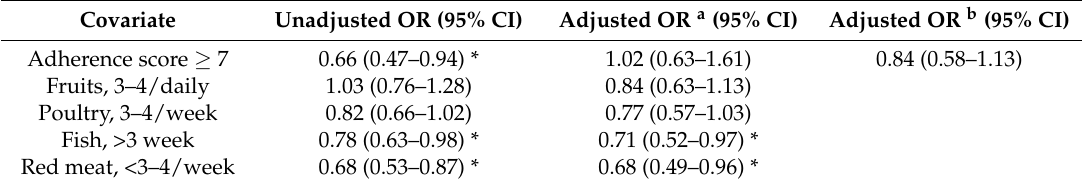
Table 7. Association between hypertension and dietary